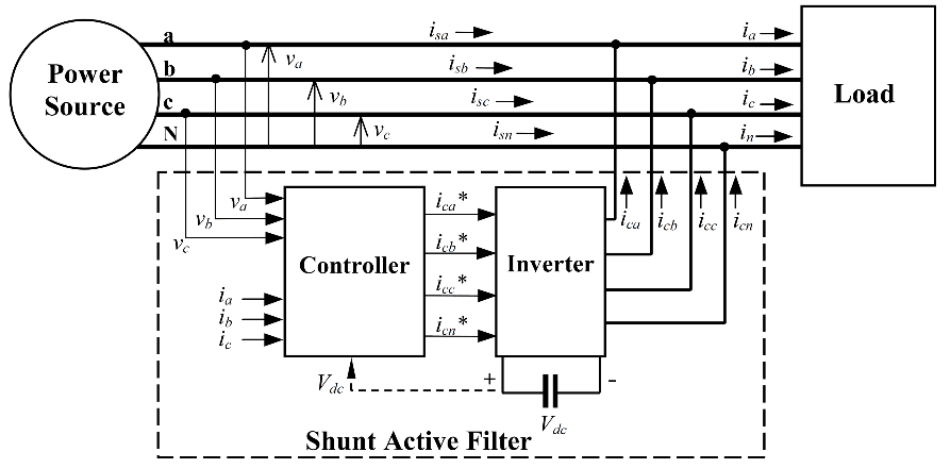
Figure 4. Shunt active power filter [27].